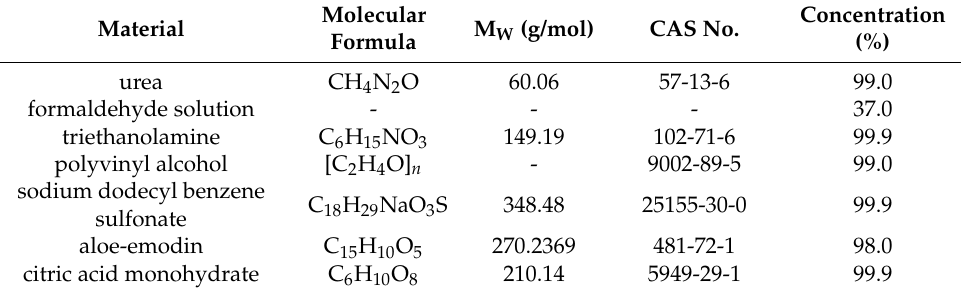
Table 1. List of the test